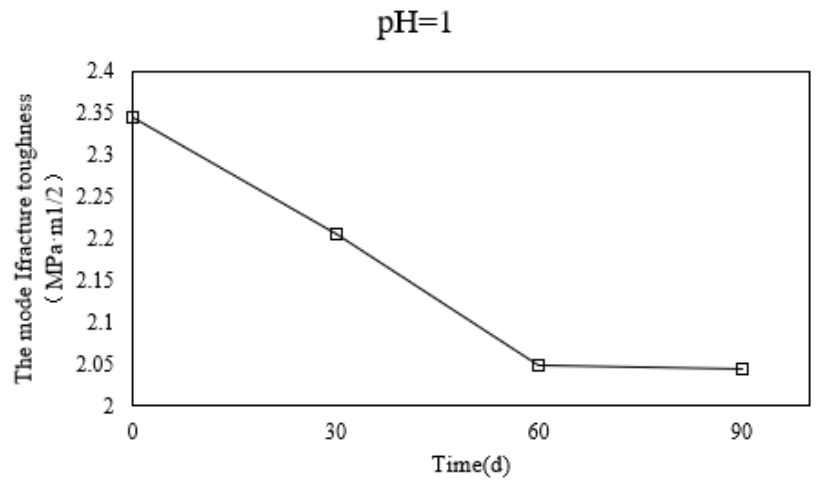
Figure 8. The K IC of tonalite specimens after nitric acid treatment at pH = 1.